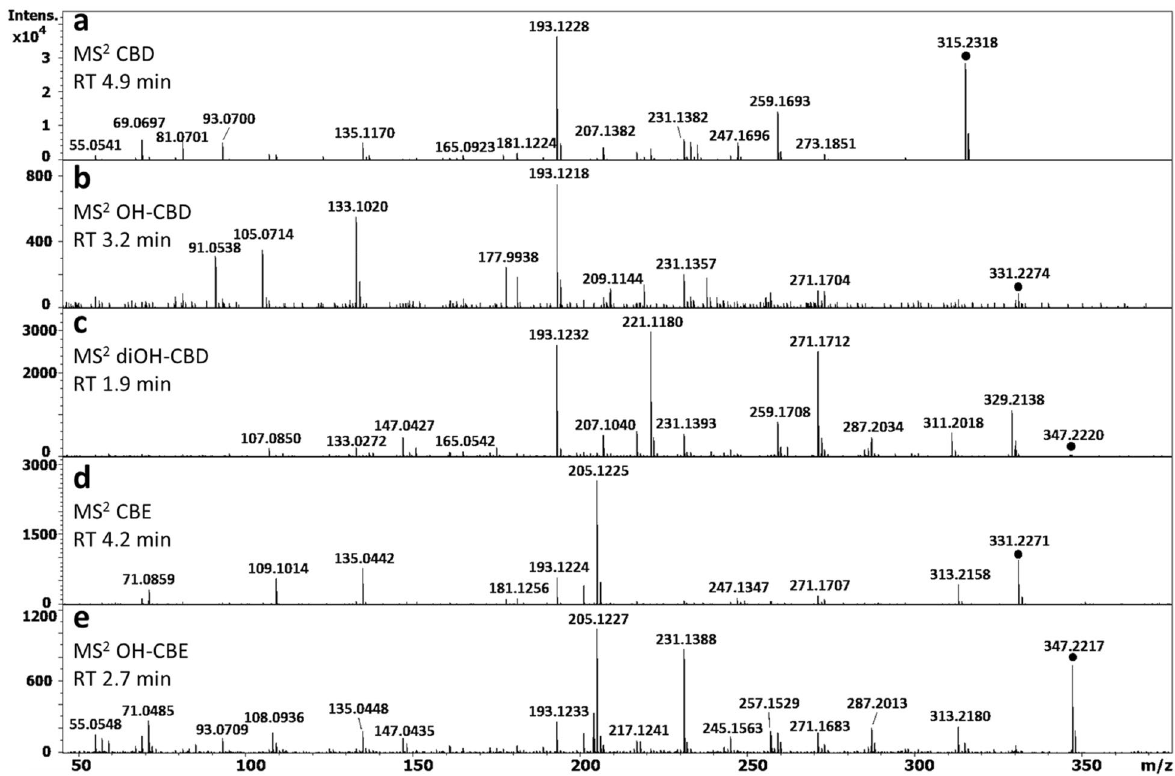
Figure 4. MS 2 fragmentation spectrum of CBD at RT 4.99 min ( a ), OH-CBD at RT 3.2 min ( b ), diOH-CBD at RT 1.9 min ( c ), CBE at RT 4.2 min ( d ), and OH-CBE at RT 2.7 min ( e